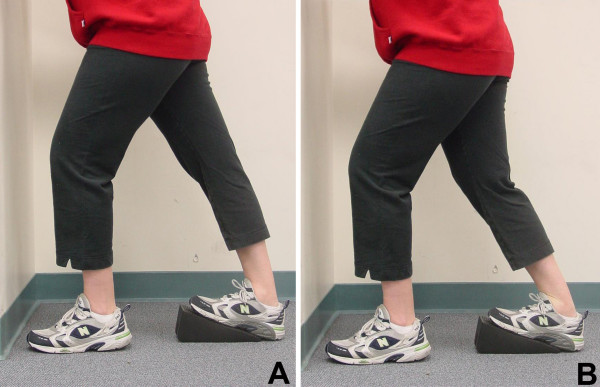
A) Standing gastrocnemius stretch. B) Standing soleus stretch.